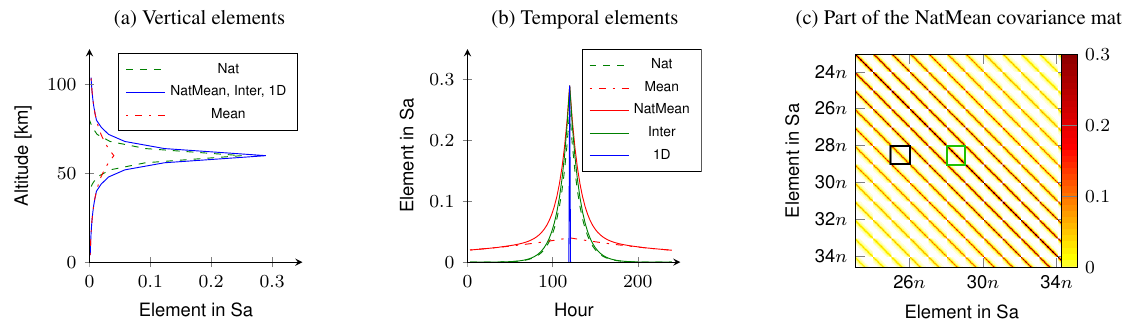
Fig. 1: The covariance matrices used for the a priori information on water vapour. Plot (a) depicts the temporal and (b) the vertical elements of the covariance matrix. The matrices represent natural variability (Nat), uncertainty in a priori mean (Mean), the sum of natural variability and uncertainty in mean (NatMean), single spectrum inversions (1D) and an intermediate covariance matrix (Inter). The structure of the NatMean a priori covariance matrix is shown in plot (c). A diagonal matrix block is highlighted by the green square and an off-diagonal block is highlighted by the black square. The axis labels are multiples of n , i.e. the length of the single spectrum state vector. represents the variance scaled with the correlation between measurement